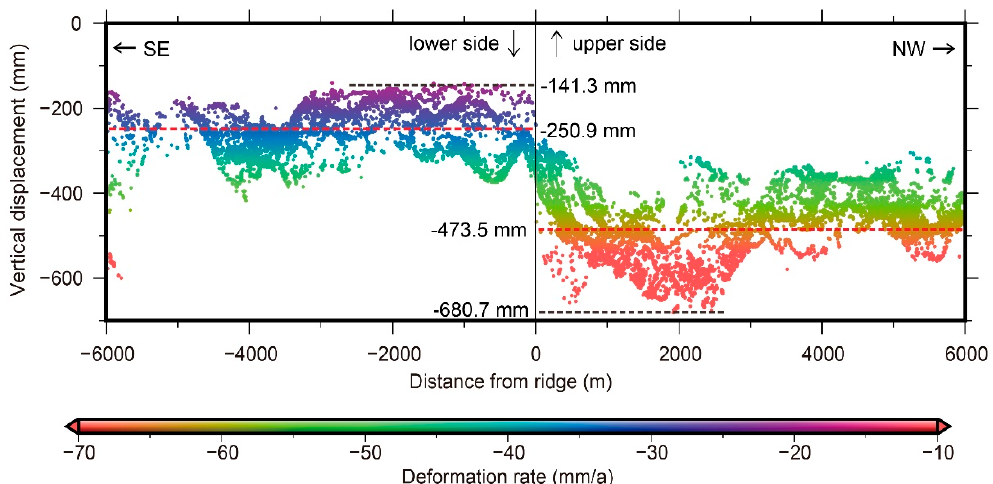
Figure 9. The profiles of InSAR vertical displacement from the points within the black box in Figure 8, colored by deformation rate. The centerline indicates the location of the identified ground fissure (marked as the red dashed line in Figure 8). The dashed black lines indicate the maximum and minimum cumulative vertical displacement and the dashed red lines indicate the average vertical displacements on both sides of the ground fissure.